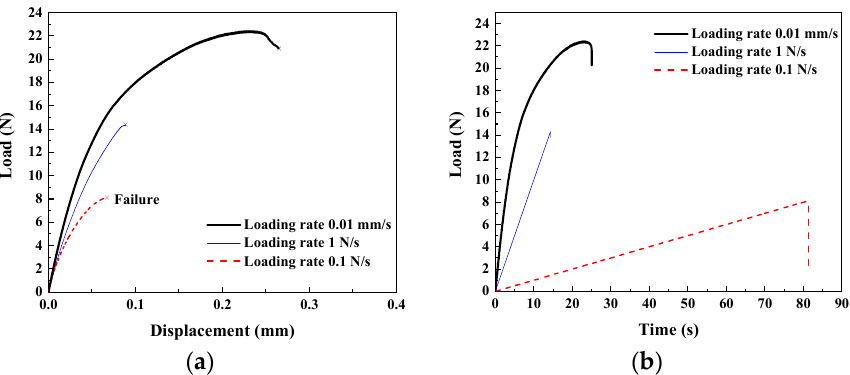
Figure 2. ( a ) Typical load-displacement curves under different loading rates until their ultimate failure. ( b ) Load-time curves corresponding to ( a ).